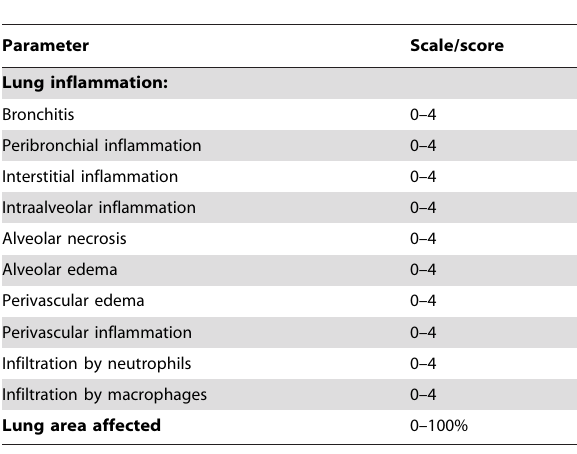
Table 1. Lung Scoring